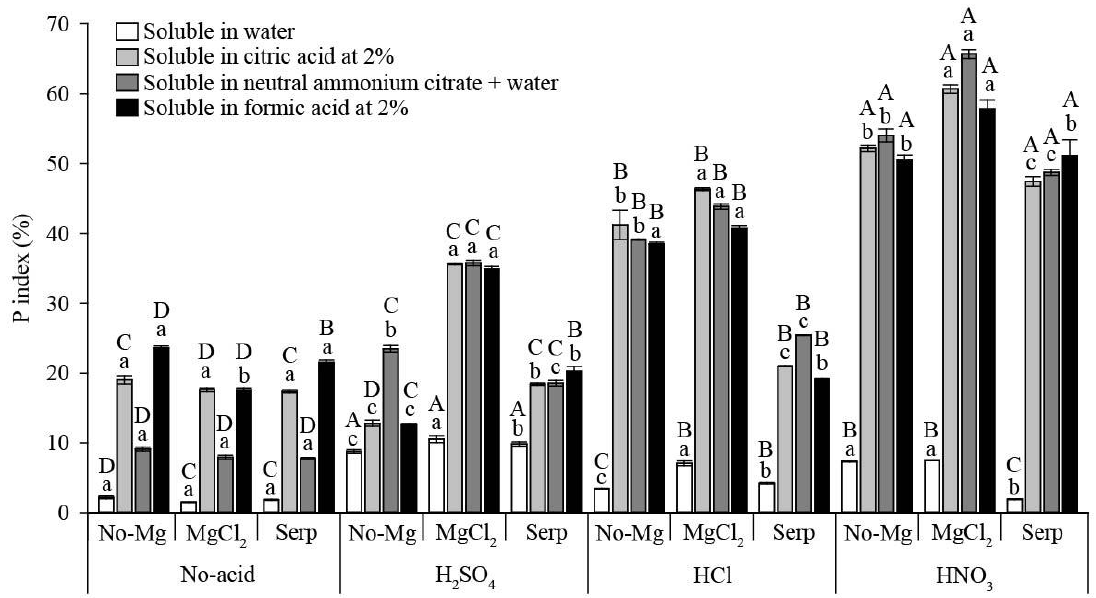
Figure 2. Biochar-based fertilizer-P solubility index of different extractant solutions, considered the P extracted as a percentage of total P concentration in each fertilizer (P index). The P fertilizer index are displayed in relation to different acid and Mg sources used previous to the pyrolysis and production of BBFs. The bars with standard error followed by the same capital letter did not differ regarding the acid treatment for each Mg source, according to the Duncan test ( p < 0.05). The bars with standard error followed by the same lowcase letter did not differ regarding the Mg source used to produce the BBFS, according to the Duncan test ( p < 0.05). No-Mg: no-Mg addition; MgCl 2 : Mg added via magnesium chloride; Serp: Mg added via serpentinite. More details of the BBFs acronyms and synthesis routes are shown in Table 1.